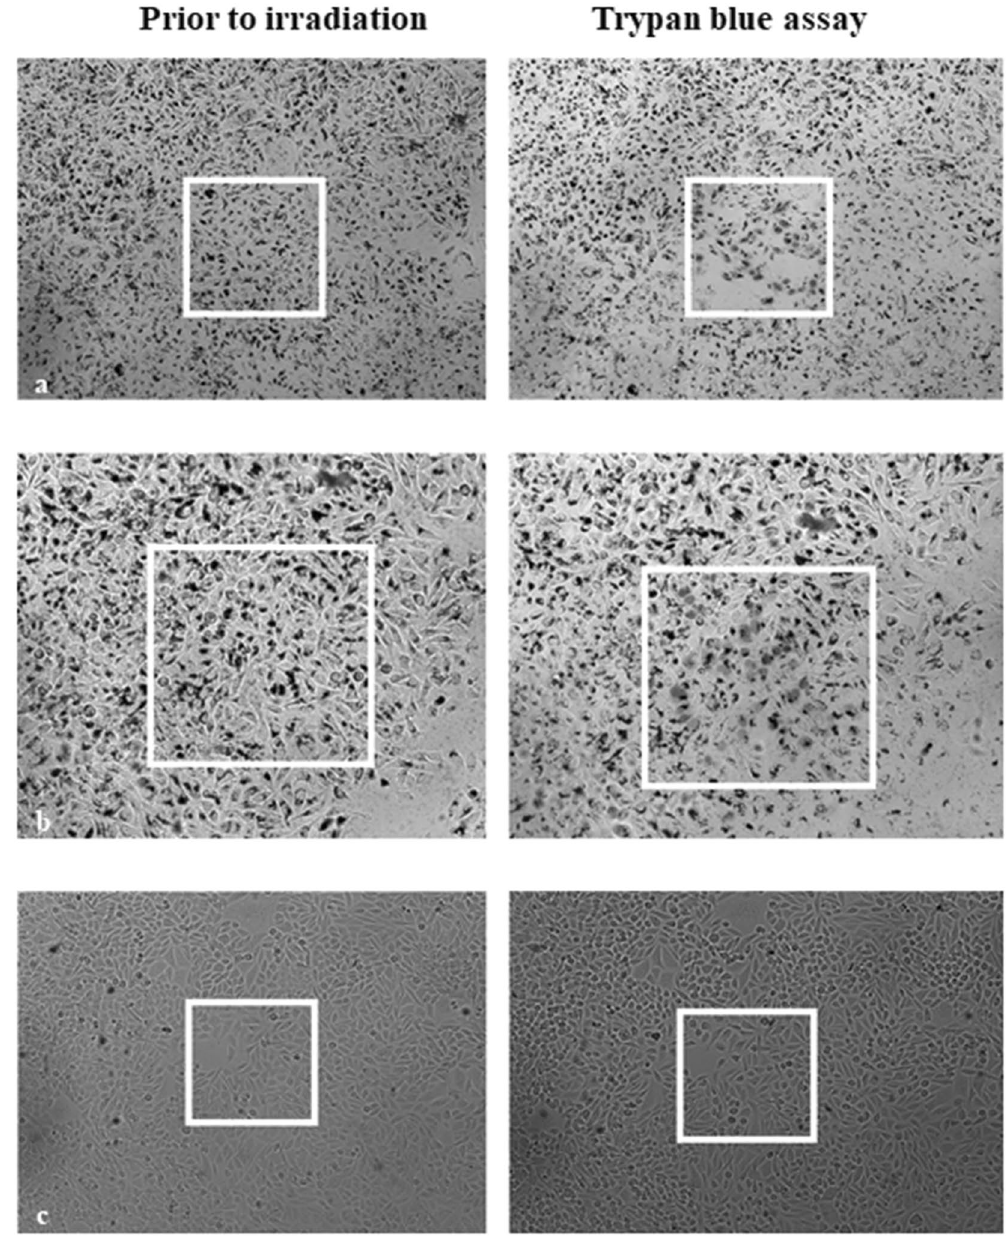
Figure 8. Phase-contrast microscopy images of HeLa cells. The white squares indicate 230 µm × 230 µm areas irradiated with a 808 nm laser. Left column : cells prior to near IR irradiation; right column : after irradiation for 31 s and application of trypan blue assay. Cells were pre-incubated with ( a ) WS 2 -NT-CM-P[PPA] or ( b ) WS 2 - NT-CM, ( c )